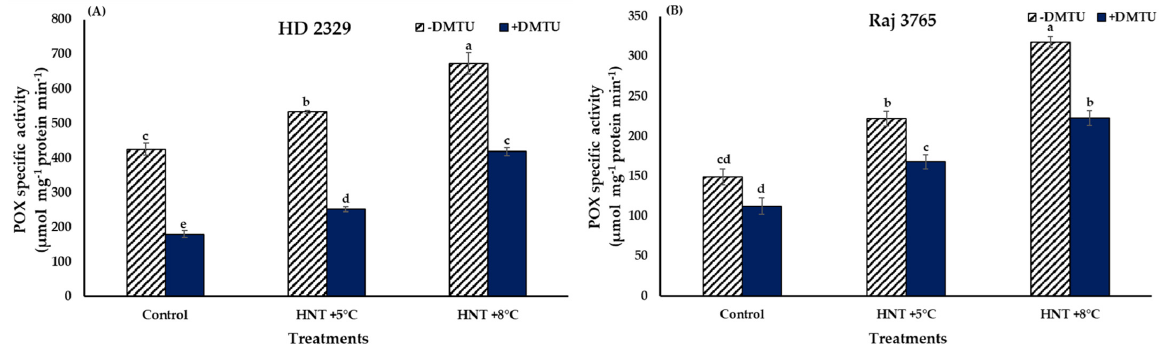
Figure 8. Effect of HNT on peroxidase specific activity in pistil of wheat genotypes ( A ) HD 2329 (sensitive) and ( B ) Raj 3765 (tolerant) under control, HNT (+5 ◦ C) and HNT (+8 ◦ C) conditions in absence and presence of ROS scavenger (DMTU). Bars represent mean ± SE. Bars with common letter are not significantly different between temperature treatments in a genotype at p < 0.05.